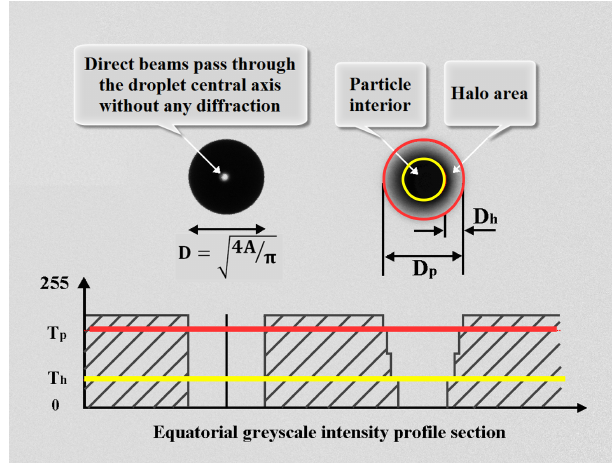
Figure 2. Schematic representation of the threshold method show- ing shadow images of two sample droplets – an in-focus droplet (left) and a defocused droplet (right) – above greyscale intensity profiles illustrating the applied thresholds.